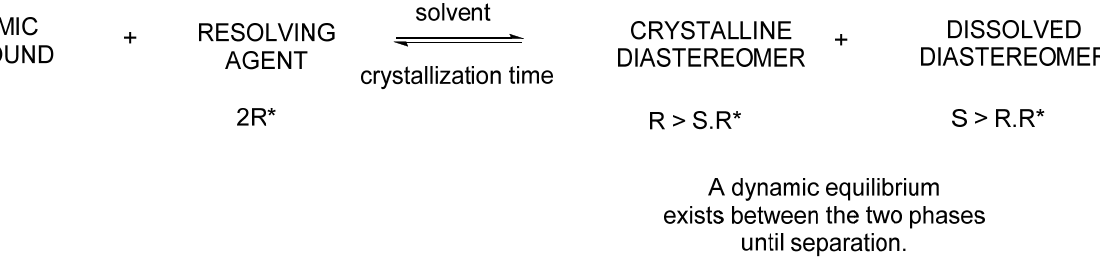
Figure 1. Schematic figure of diastereomeric salt-forming separation.